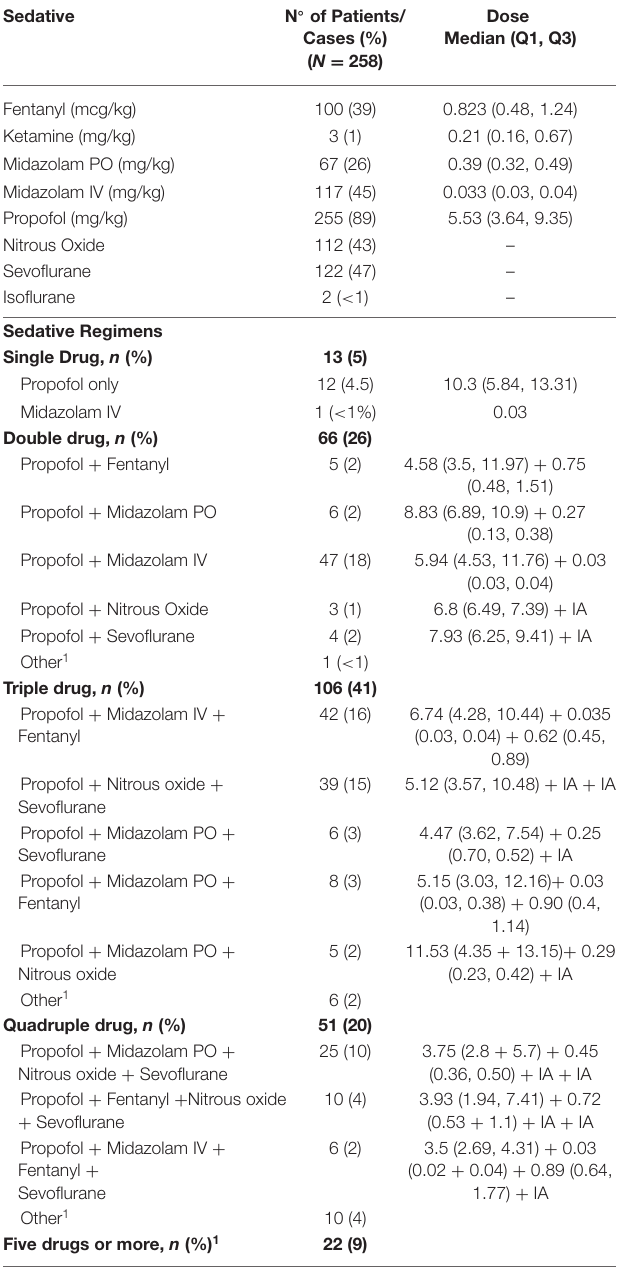
TABLE 2 | Descriptive information about sedatives, as well as single and combination drug regimens, including frequency of use and PO/IV doses used. Sedative N ◦ of Patients/